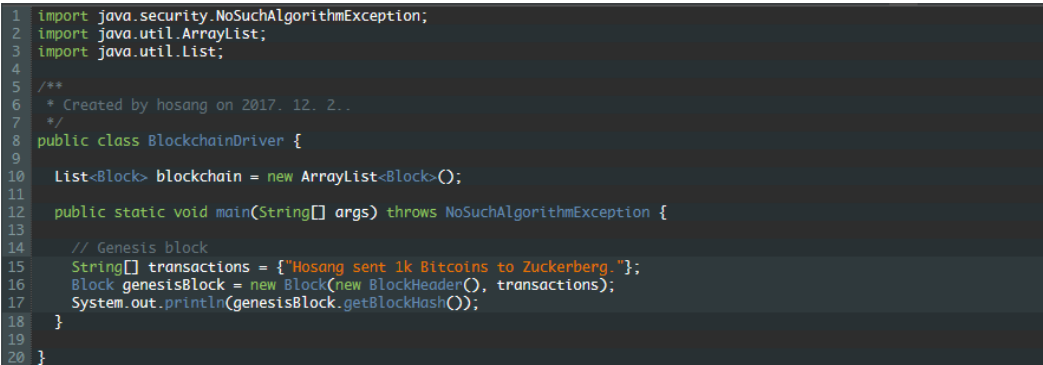
Figure 11. Generation of original block (genesis block) and output of the block hash value.